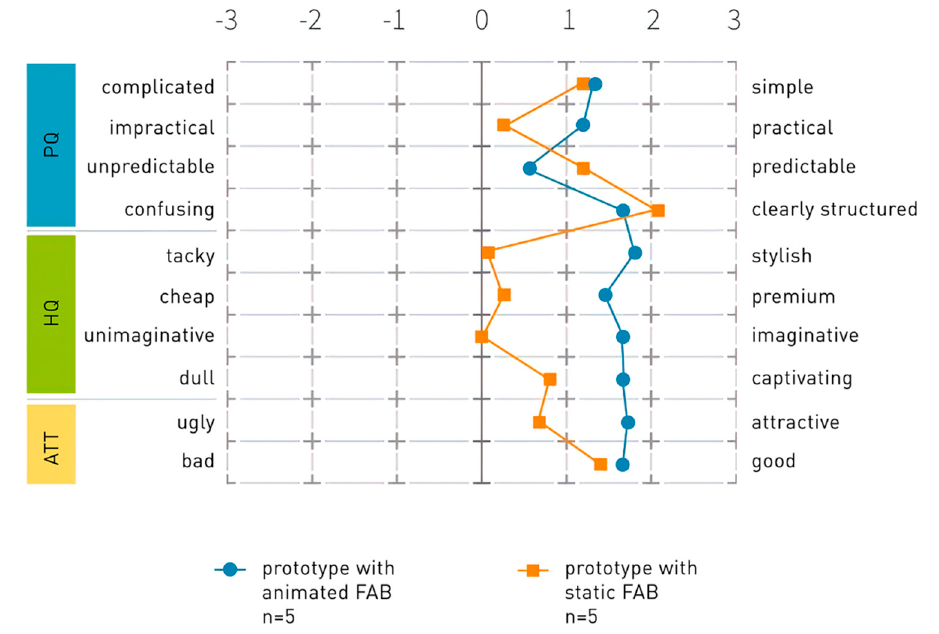
Figure 3. Diagram of perceived qualities of videos B1 and B2.